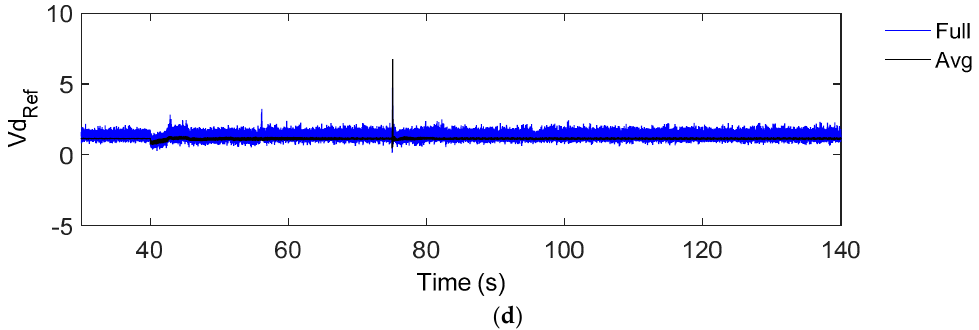
Figure 19. Control reference signals when microgrid is islanded and followed by different transients: ( a ) I q , ( b ) I d , ( c ) V q , ( d ) V d .